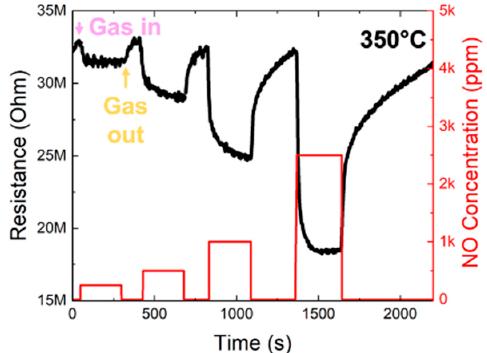
Figure 2. Dynamic resistance variations of the WO 3 -based sensor (black curve) at 350 °C under cy- cles of different NO concentrations (red curve). The arrows indicate when NO was fluxed into the chamber (named “gas in”) or it was stopped (named “gas out”), which coincided with the start of the response and the recovery phases, respectively.